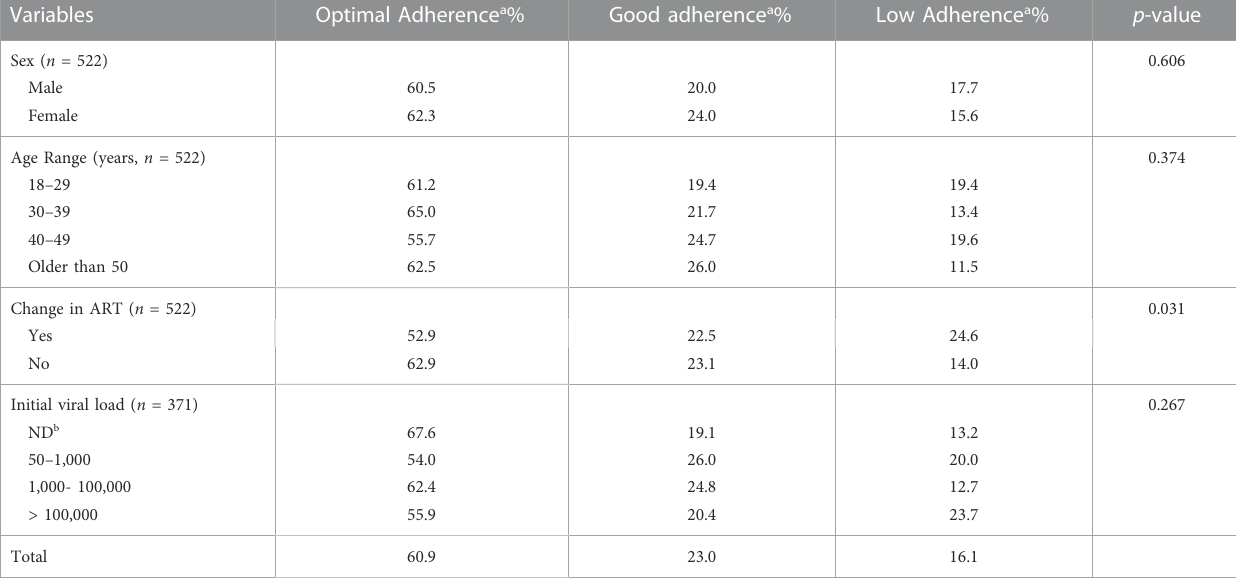
TABLE 4 Antiretroviral therapy adherence in people living with HIV/AIDS, according to demographic, therapeutic and clinical characteristics, Hospital Universitário de Brasilia, Brasilia, Brazil, 2019. Variables Optimal Adherence a % Good adherence a % Low Adherence a % p -value